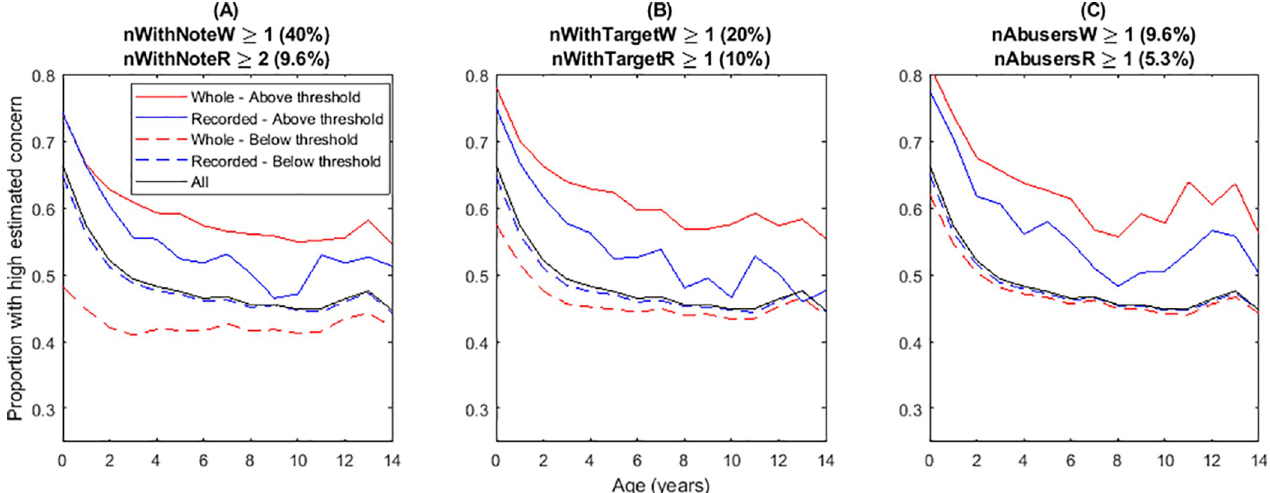
Fig 2. Whole-life relationships are consistently better than recorded relationships for identifying high-risk groups. Each panel shows the incidence rate of high estimated concern when children are split into two groups according to a threshold value (determined by a single-split classification tree) of a single network-based predictor variable at the time of their first notification. Above each graph is shown the predictor variable being used (see Table 1 for definitions), the threshold value used to group the children, and the proportion of children in the above-threshold (high-risk) group. The difference in the incidence rate between the high-risk and low-risk groups is always greater using whole-life relationships (red) than using recorded relationships (blue).